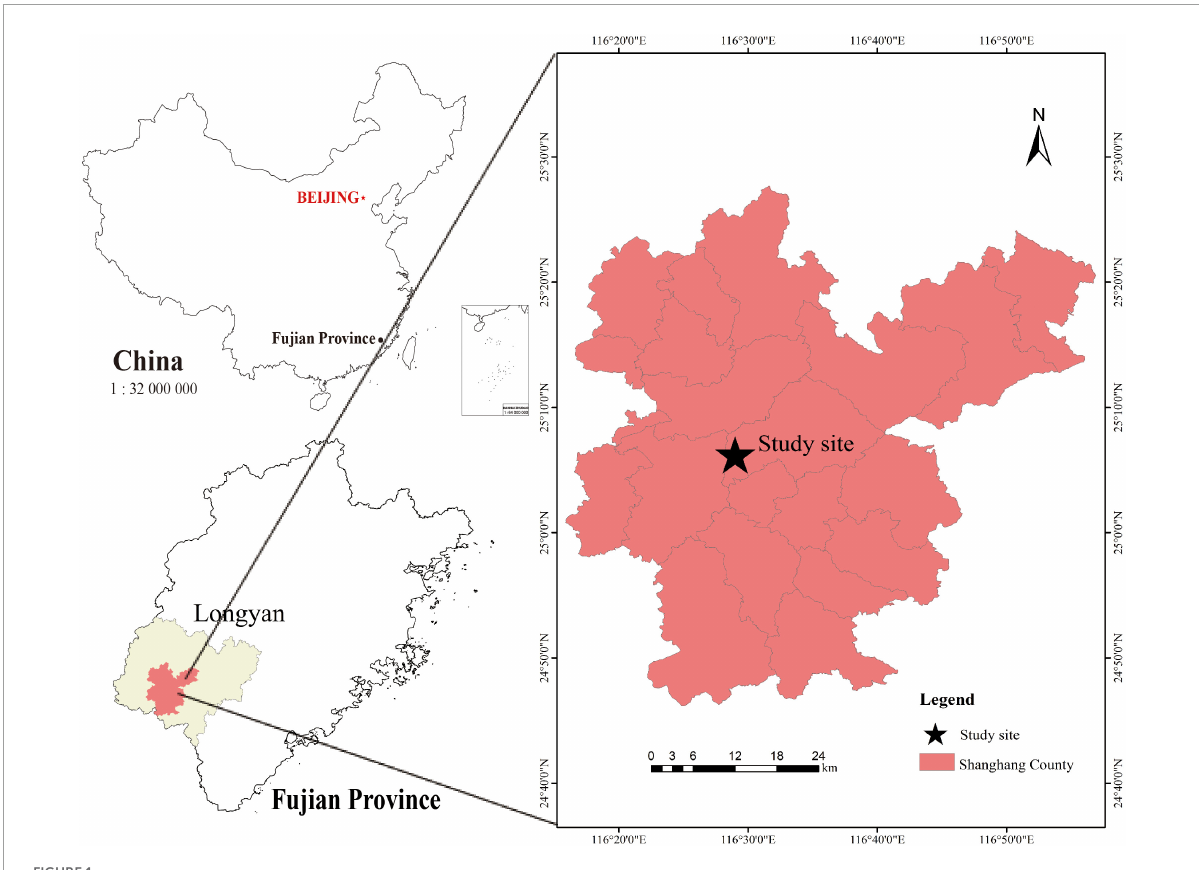
FIGURE1 The map of the study area (Longyan City, Fujian Province, 116 ◦ 37 (cid:48) 53 (cid:48)(cid:48) E—116 ◦ 37 (cid:48) 59 (cid:48)(cid:48) E, 25 ◦ 09 (cid:48) 46 (cid:48)(cid:48) N—25 ◦ 09 (cid:48) 51 (cid:48)(cid:48)